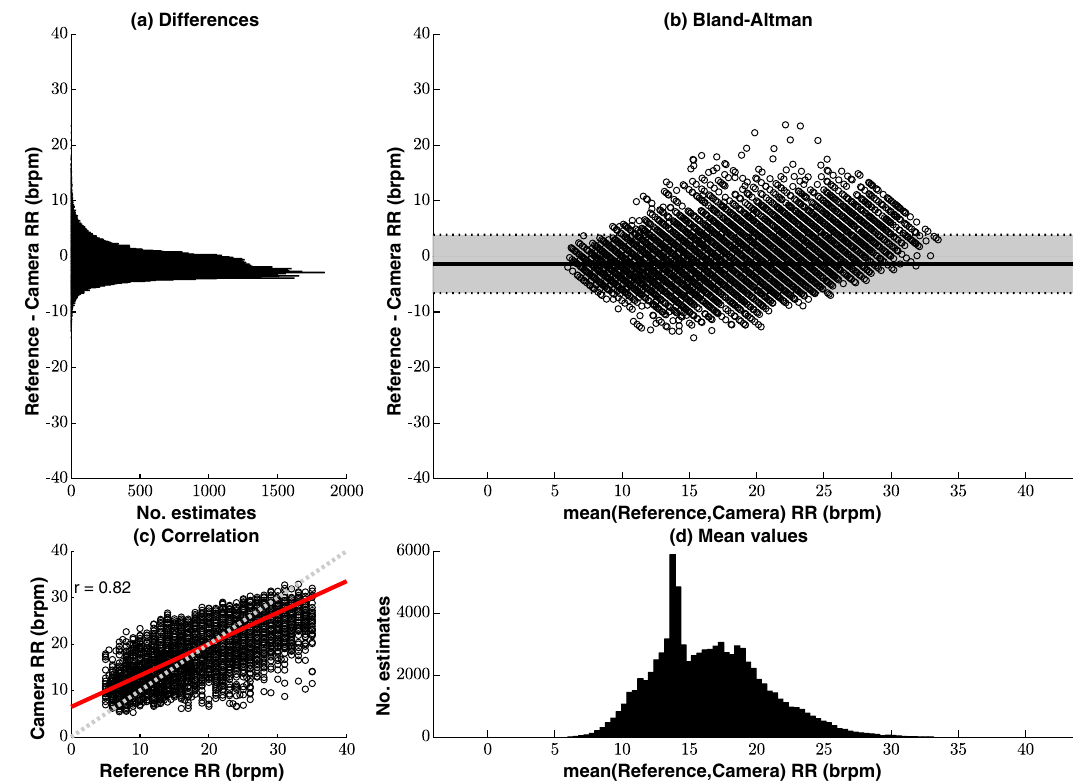
Fig. 2 Agreement between the reference respiratory rate values (computed from the chest impedance pneumogram) and the camera estimates for the valid video camera data, comprising a total estimated time of approximately 119.8 h. a The differences between the two estimates. b The Bland-Altman plot presents negligible sensor bias. c The plot shows a positive correlation between the two devices, with a Pearson correlation coef fi cient of 0.82. d The distribution of the mean values shows that most of the respiratory rate estimates are within the expected physiological range for adults. brpm =